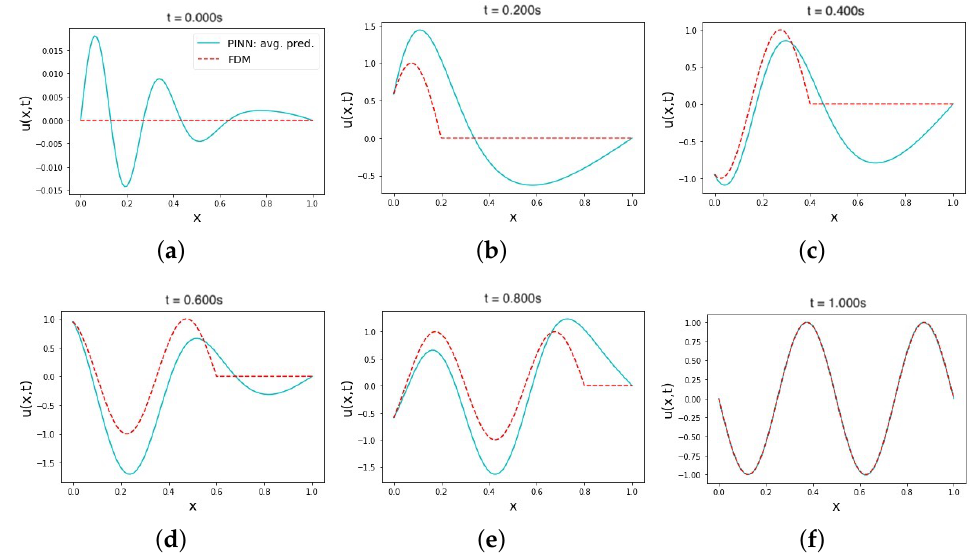
Figure 5. The average predicted solution of the wave equation using a PINN with soft initial constraints and hard boundary constraints (soft–hard). Plots ( a – f ) show the average prediction values of the five most accurate trials of multiple time instances in the range [0, 1]. The rest of the trials that reflected an L2 relative error > 1.0 were excluded. All training points are sampled uniformly from the domain in all